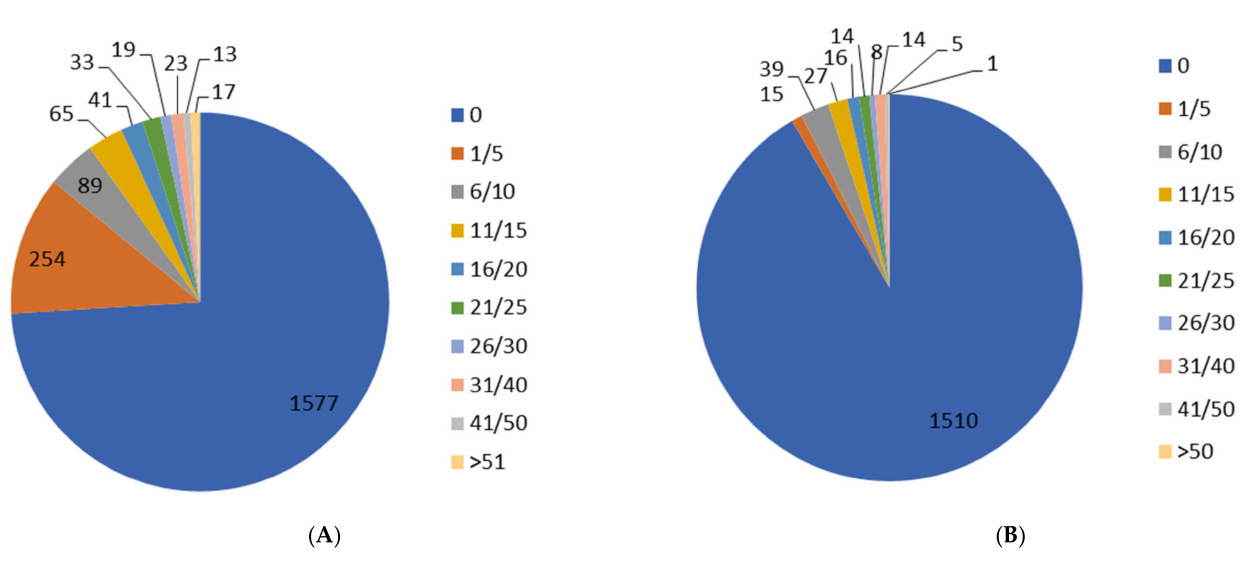
Figure 3. Chart depicting the distribution of male animals in the total population ( A ) and in the reference population ( B ) per class of offspring